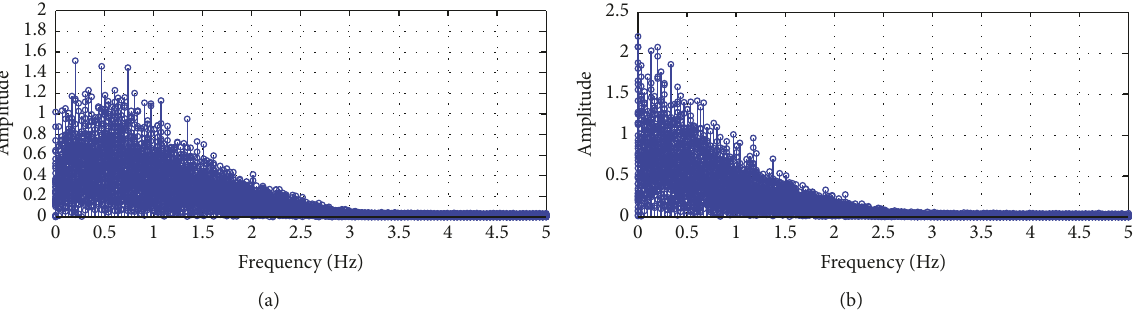
Figure 10: Frequency spectrums of the collected motion data through USV-operation simulations under Sea State 3. (a) Roll motion; (b) pitch motion.